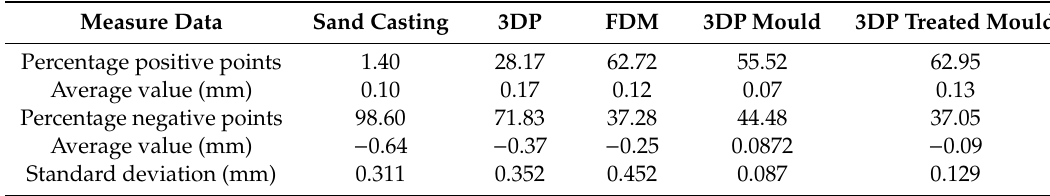
Table 6. Upper and lower deviations for both techniques.